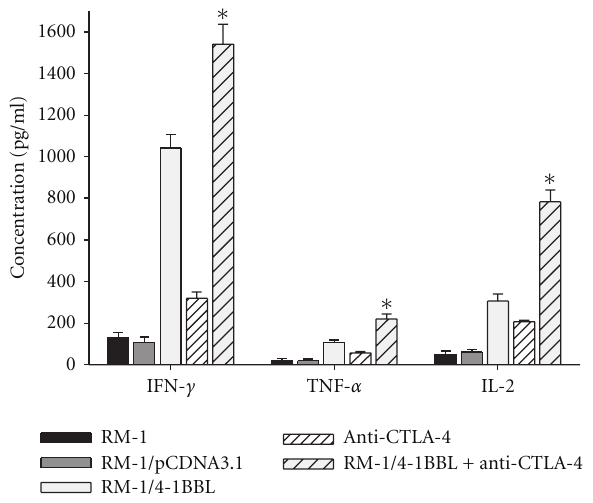
Figure 4: Cytokine ELISA. Spleens were harvested from mice rejecting RM-1 cells and restimulated in vitro with MMC-treated RM-1 cells. 7d later, cells were collected and purified by Ficoll- Histopaque gradient centrifugation as e ff ector cells coculturing with RM-1 cells. The The supernatant was collected and tested for the presence of IFN- γ , TNF- α and IL-2 by ELISA ( ∗ P < 0 . 05).